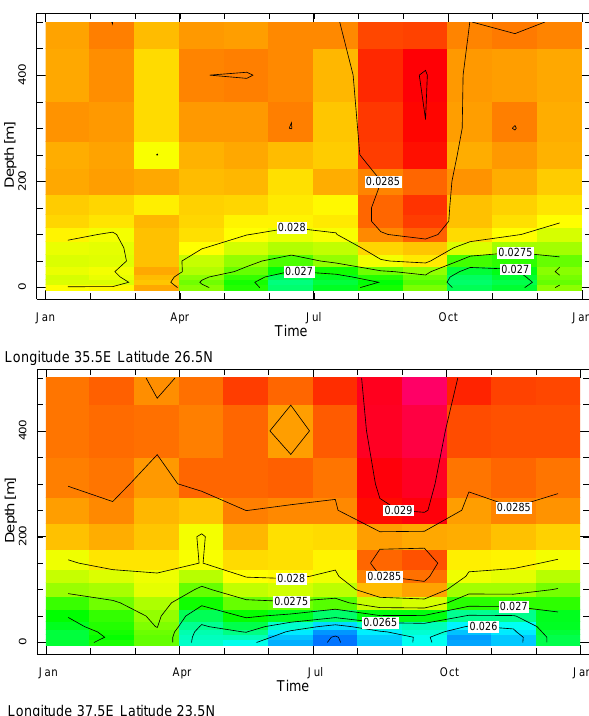
Fig. 2. Monthly potential density for the Red Sea (Levitus,